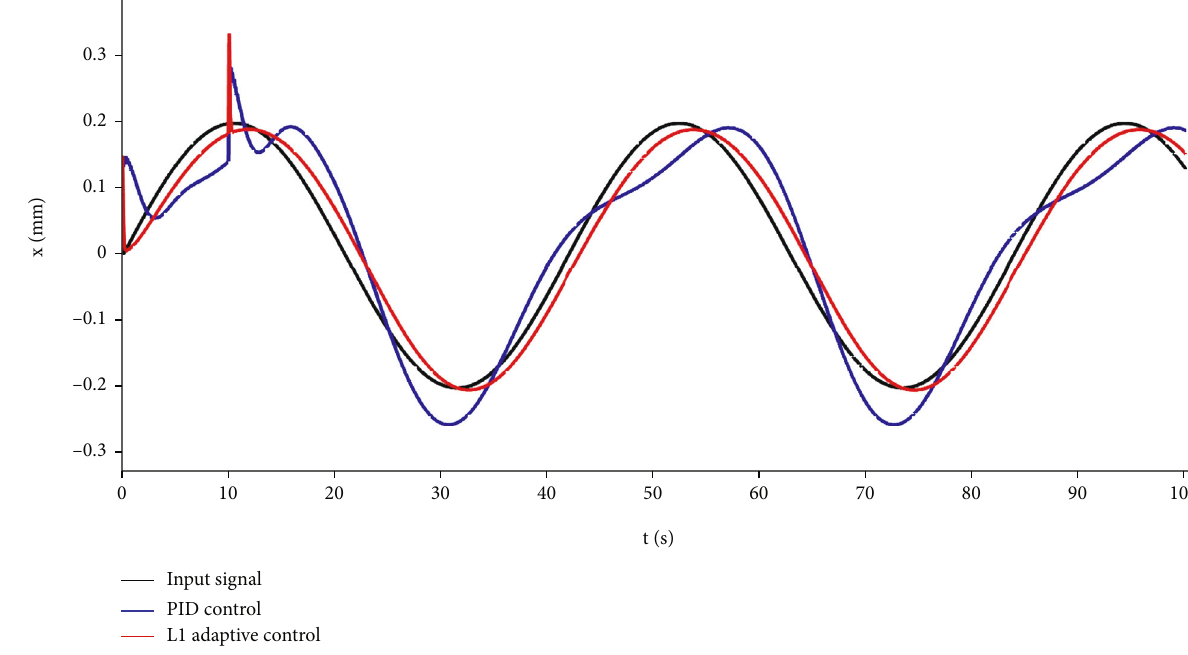
Figure 12: Input sine signal to track signal response in high-frequency